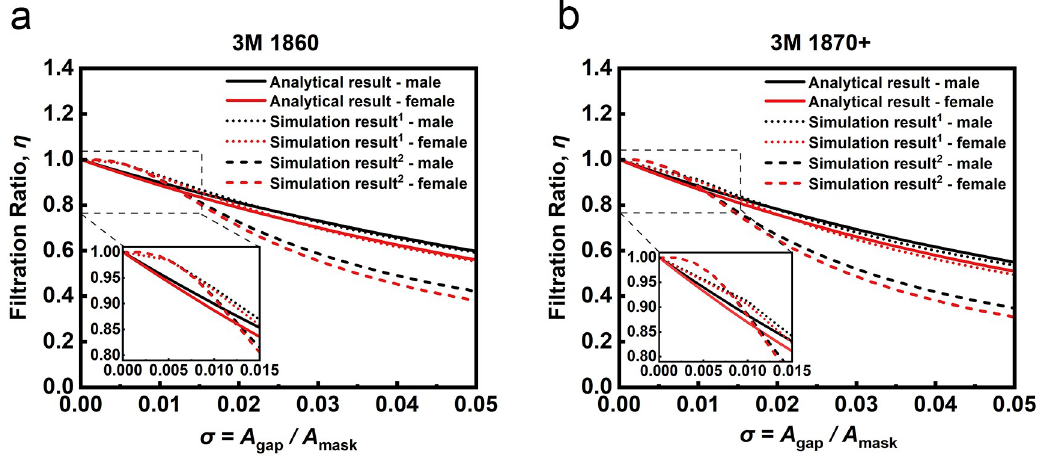
Fig 6. The dependences between η and σ for (a) 3M 1860 and (b) 1870+ masks. Dotted lines, 1, with W mouth = W mask + W gap . Dashed lines, 2, showing the case a finite modelled mouth width W mouth = 0.00463 m.